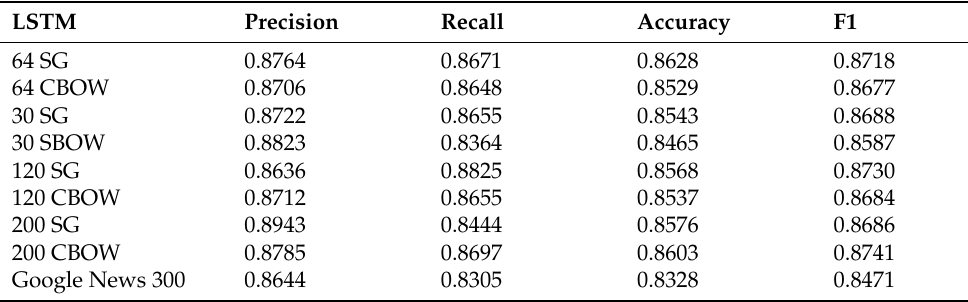
Table 4. Effectivity of LSTM model with the topology presented in the Table